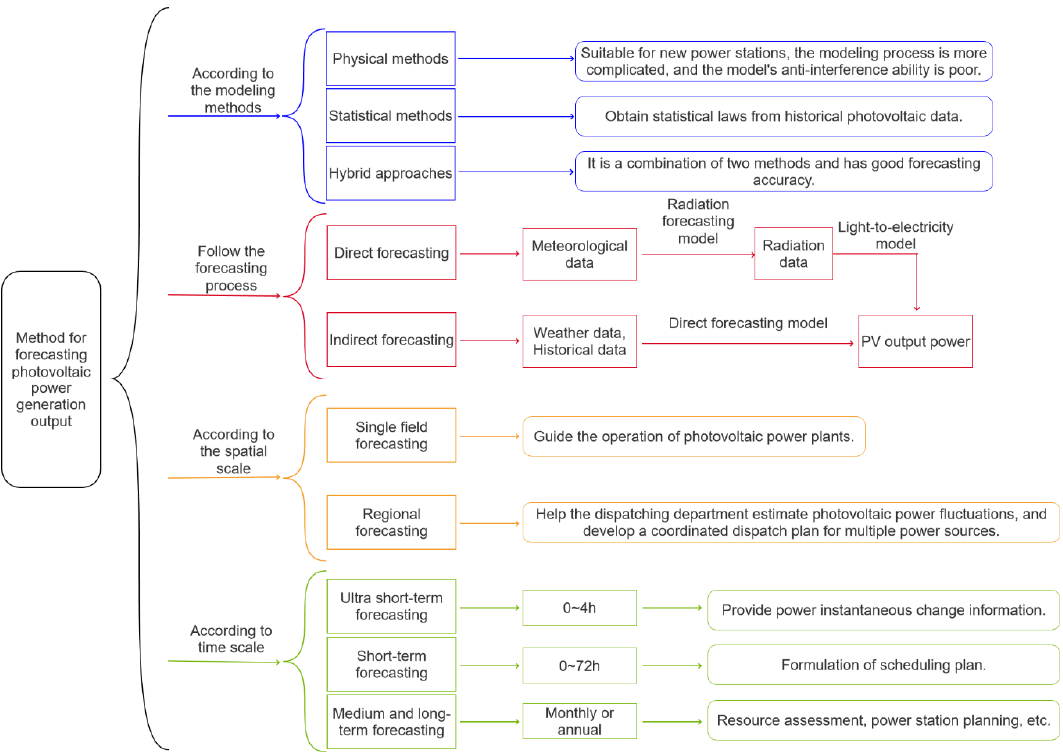
Figure 2. Classification of forecasting methods for PV power output.